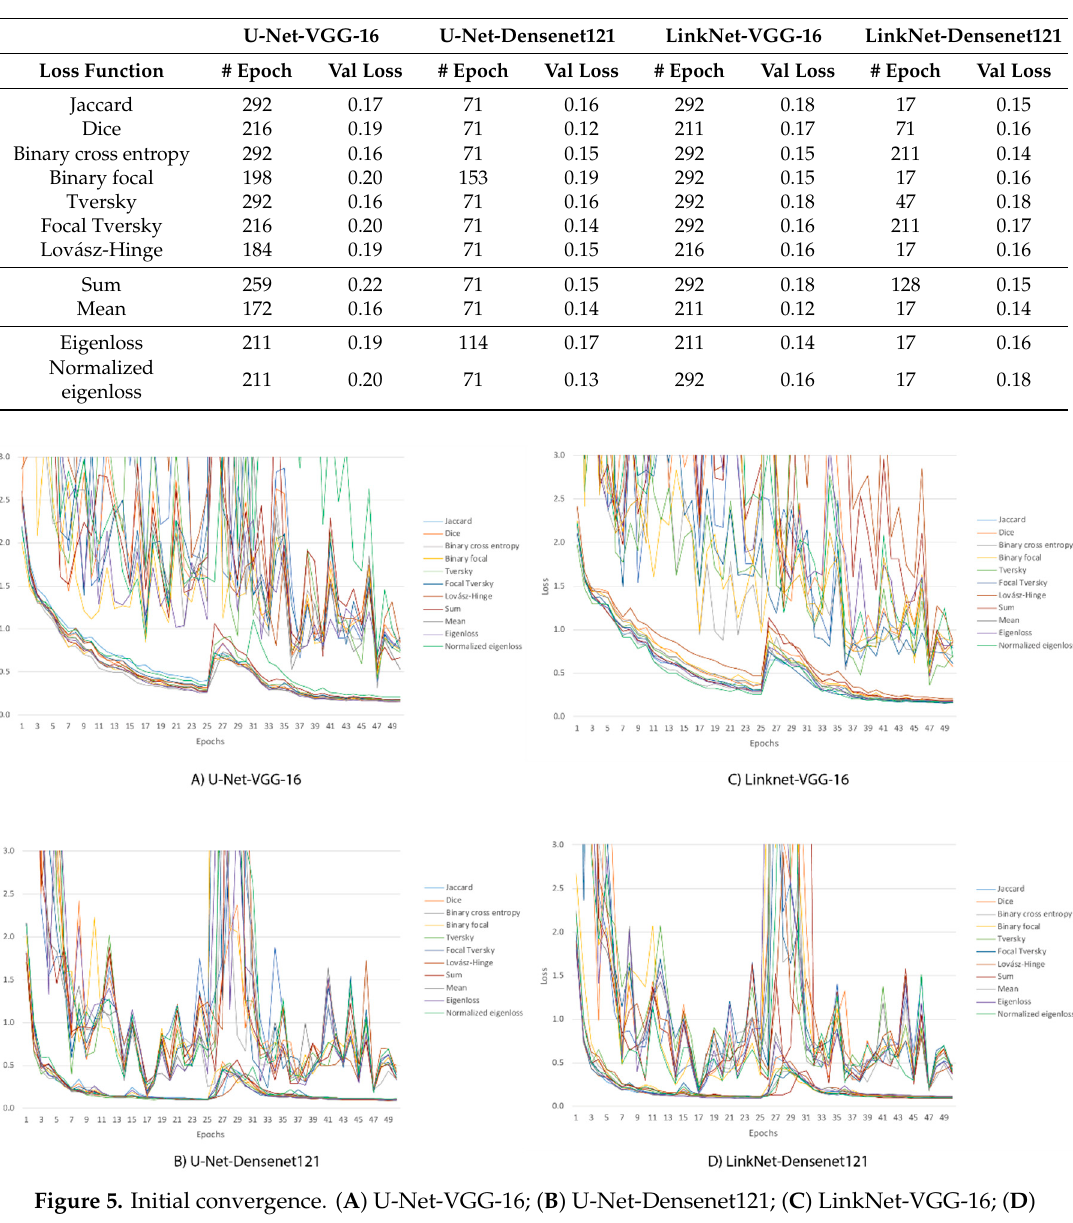
Table 6. Best epoch (# Epoch) and value of the validation loss (Val Loss) for each model and loss function.